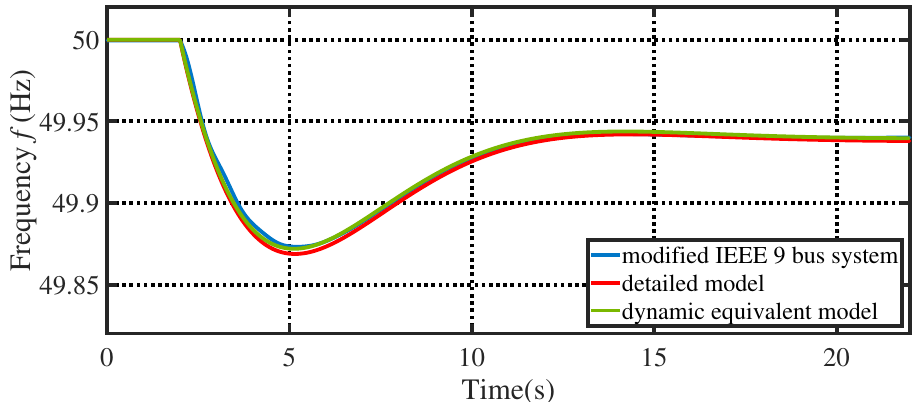
Figure 16. Grid frequency dynamics of the modified system, the detailed model and the dynamic equivalent model during the under-frequency event.